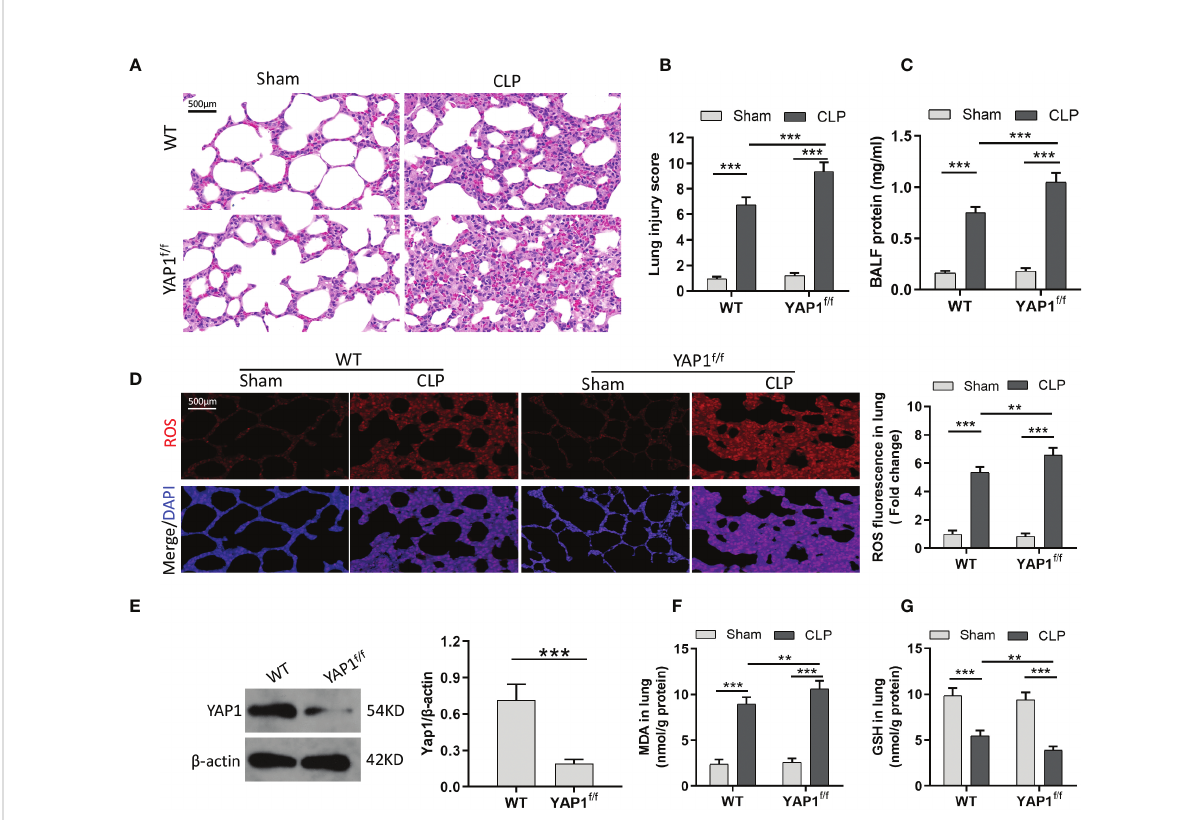
FIGURE 5 YAP1 de fi ciency aggravated oxidative stress-mediated lung injury in CLP mice. (A) Histological images of lung samples exhibited by HE staining in mice following CLP, YAP1 f/f , and CLP+YAP1 f/f treatment. (B) The pathological lesion scores. (C) The content of BALF protein. (D) Representative fl uorescent images of ROS staining and the quanti fi cation of ROS fl uorescence intensity in lung tissue. (E) The certi fi cation of YAP1 conditional knockout in mice pulmonary epithelial cells. (F – G) Pulmonary content of MDA (F) and GSH (G) was assessed by the corresponding commercial kit. Data are expressed as mean ± SD. n = 6; * p < 0.05, ** p < 0.01, *** p <